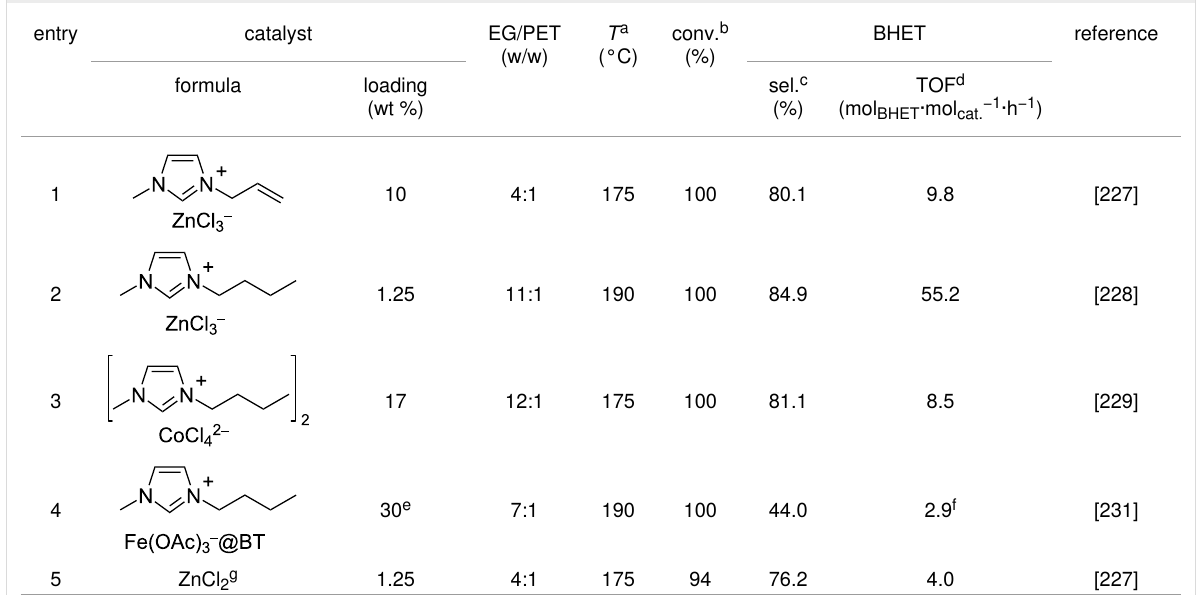
Table 4: Catalytic EG glycolysis of PET using metallated ionic liquids.